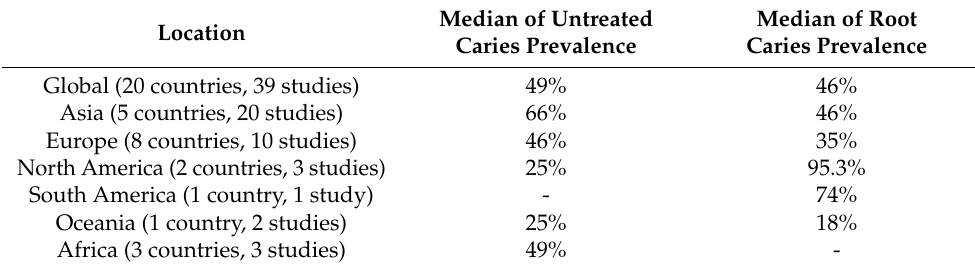
Median of Untreated Caries Prevalence